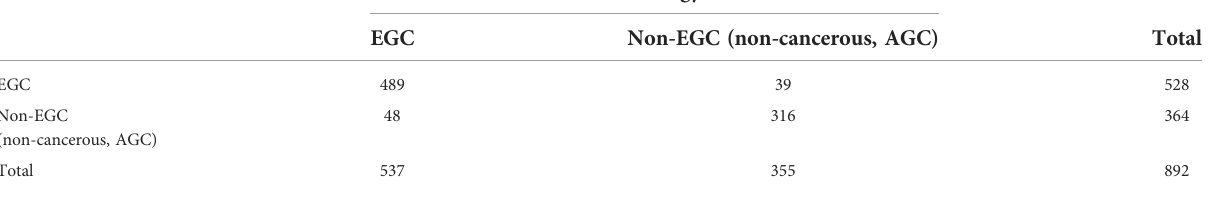
TABLE 2 Performance of the Mask R-CNN system in white light images. Mask